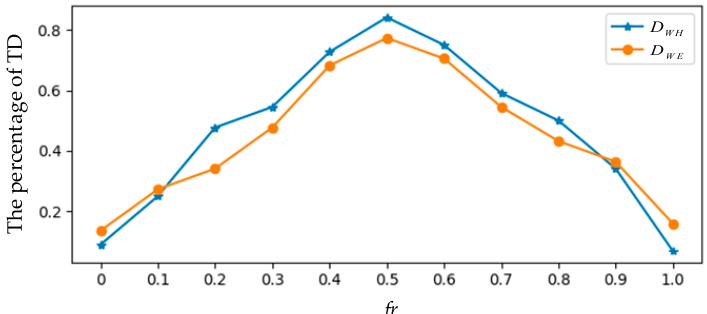
Figure 3. The plots of the percentage of TD with different fr .